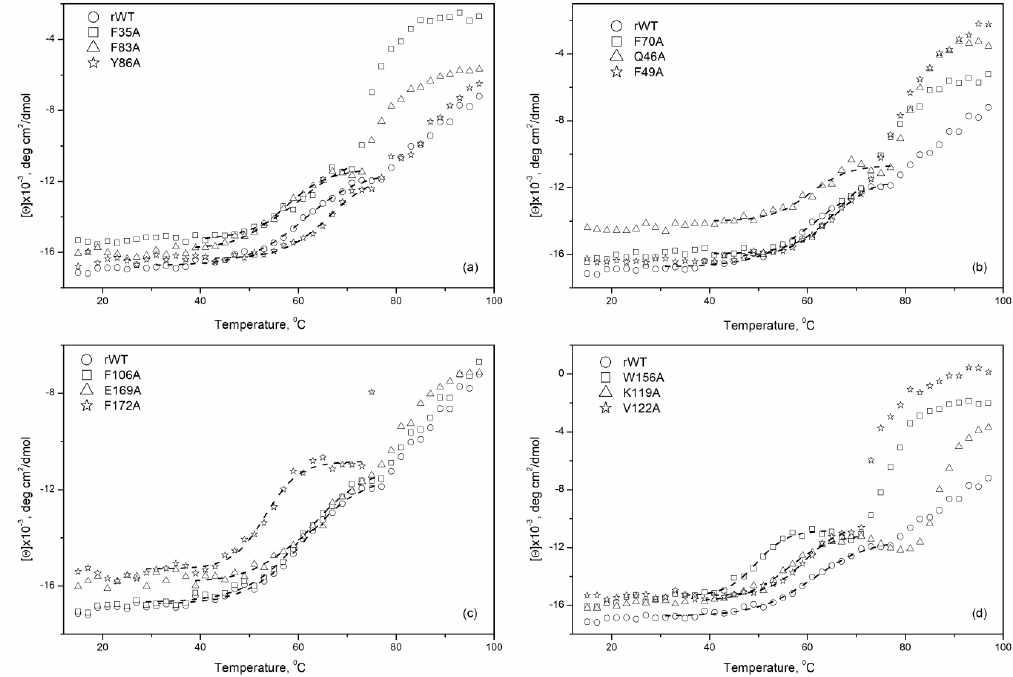
Figure 4. Temperature dependencies of molar ellipticity for apo-states of rWT human recoverin and its cluster mutants (( a )—‘black’ cluster of N-domain, ( b) —‘gray’ cluster of N-domain, ( c) —‘black’ cluster of C-domain, ( d )—‘gray’ cluster of C-domain). 20 mM Tricin-KOH, pH 7.4, 50 mM KCl, 1 mM EDTA-KOH, 20 µM DTT. Protein concentration 3.3–3.7 µM. Theoretical curves computed according to a sigmoidal function and fitted to the experimental data are shown by dotted lines.